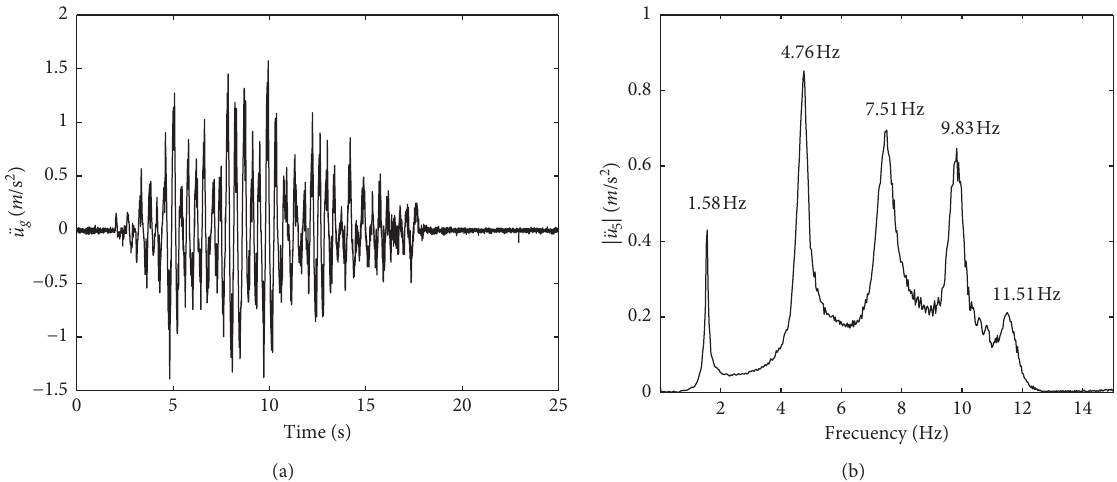
Figure 5: Seismic excitation and structural response bandwidth. (a) Excitation signal: 1985 Mexico City earthquake, North-South component. (b) Vibration frequencies of the building